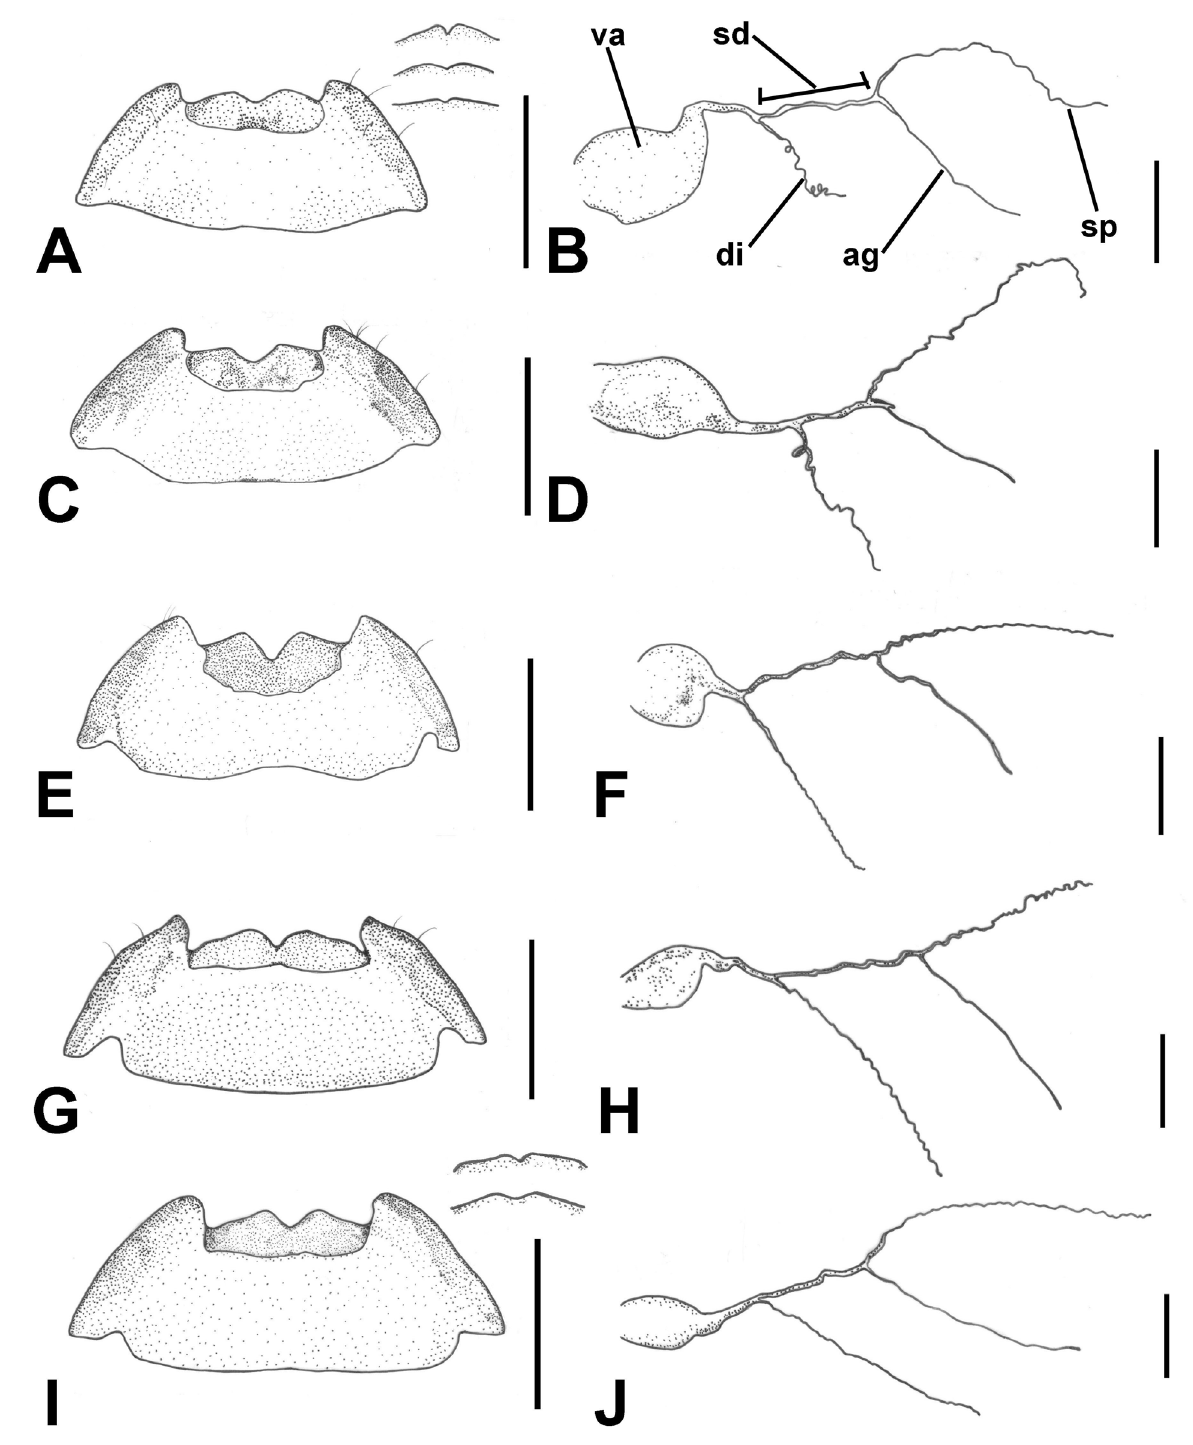
Fig. 6. A–B . Lycocerus pictus (Wittmer, 1983). C–D . L. yitingi Hsiao & Okushima sp. nov. E–F . L. nigripennis (Pic, 1938). G–H . L. aurantiacus Hsiao & Okushima sp. nov. I–J . L. evangelium Hsiao & Okushima sp. nov. A, C, E, G, I. Abdominal ventrite VII of female. B, D, F, H, J. Female genitalia, lateral view. Scale bars: A, C, E, G, I = 1.0 mm; B, D, F, H, J = 0.5